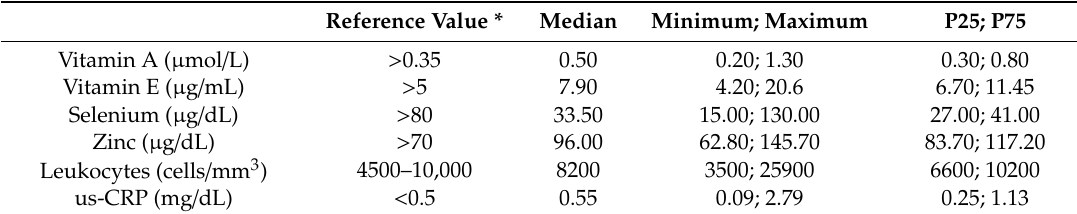
Table 3. Serum concentrations of antioxidant nutrients and inflammation markers in sickle cell disease patients ( n =